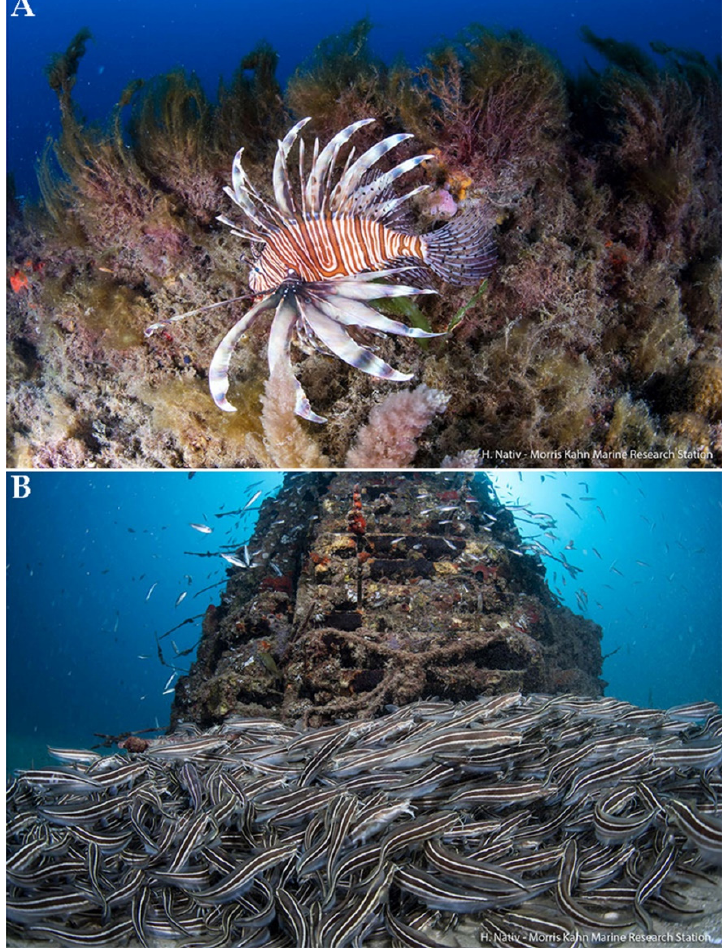
Figure 7. Lessepsian invasive venomous marine fish on the Mediterranean coast of Israel: ( A ) lion- fish and ( B ) a school of striped eel catfish near an artificial reef (photograph by Hagai